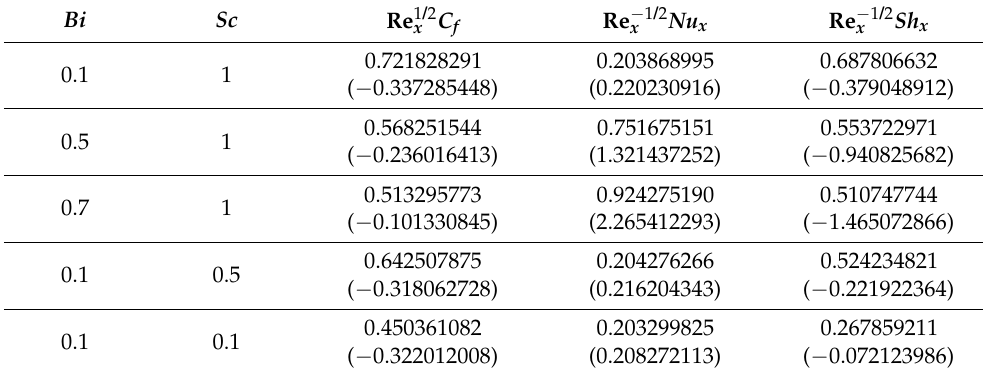
Table 7. Values of Re 1/2 x C f , Re − 1/2 x Nu x and Re − 1/2 x Sh x for different Bi and Sc